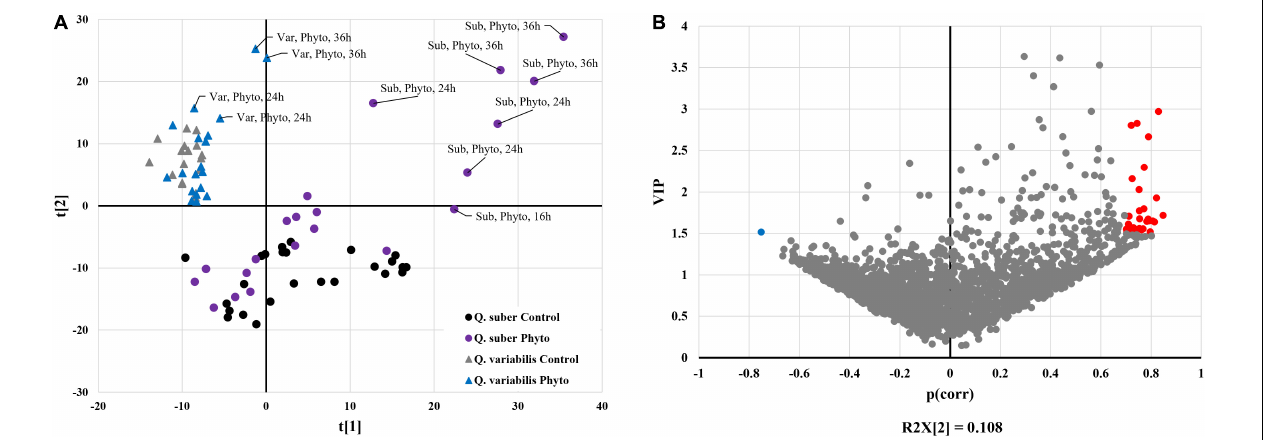
FIGURE 3 | Partial least square discriminant analysis (PLS-DA) loading plot (A) and scatter plot p(corr)/VIP (B) based on the abundance of every significantly affected Quercus root protein and the total amount of Phytophthora proteins found in the roots of Q. suber and Q. variabilis plants. Highlighted proteins have a VIP